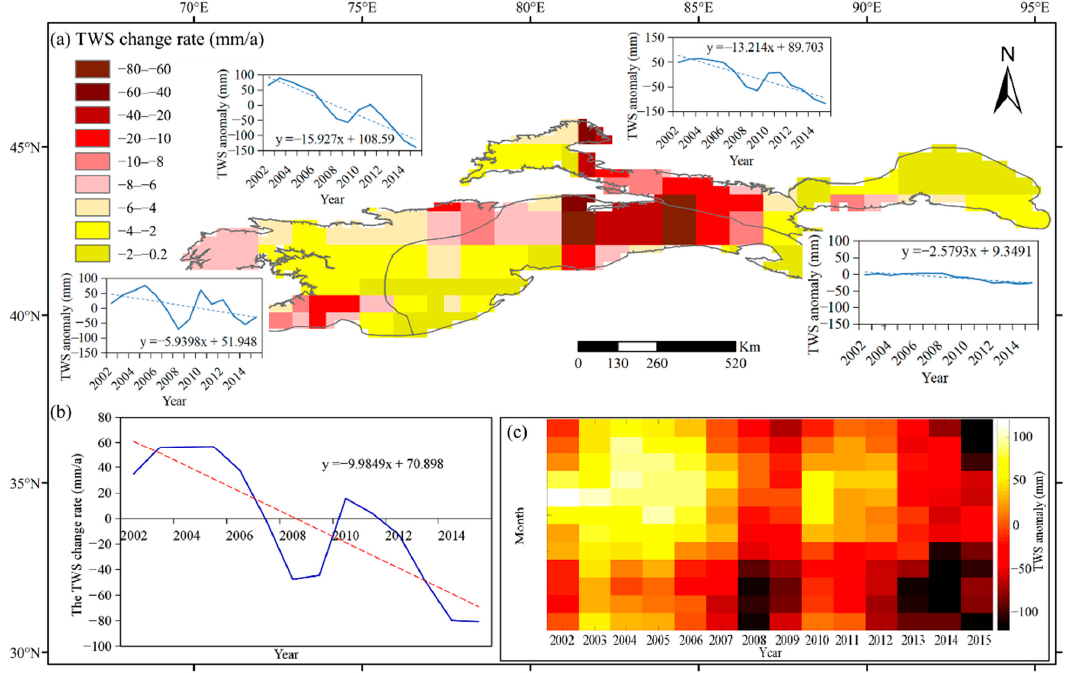
Figure 11. Variations in total water storage in the Tien Shan region. ( a ) Spatial variations in total water storage; ( b ) variations in annual total water storage; ( c ) variations in monthly total water storage.